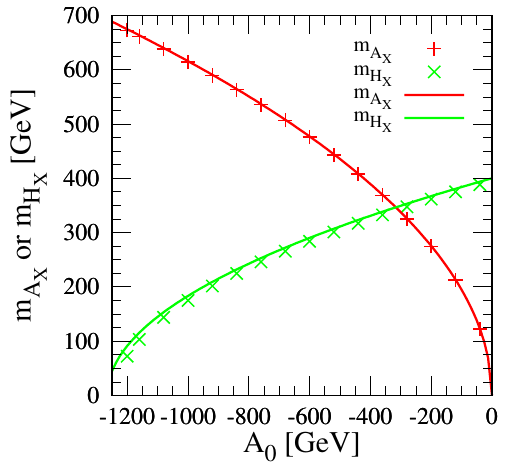
Figure 2 . Comparison of the analytic results (straight lines) for the masses of H X and A X (eqs. (3.46) and (3.47)) with numerical SPheno results (crosses) as a function of A 0 . Here, we take (cid:20) = 0 : 4 and p 2 v X = 10 3